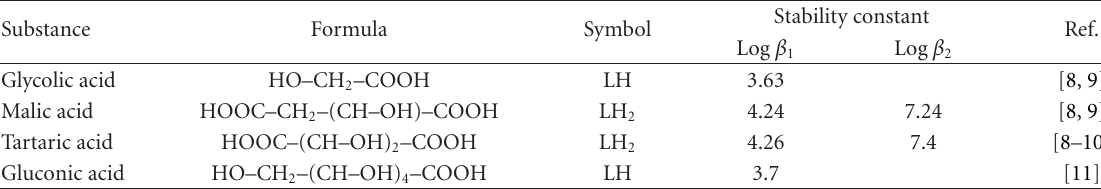
Table 1: Selected stability constants of organic acids.